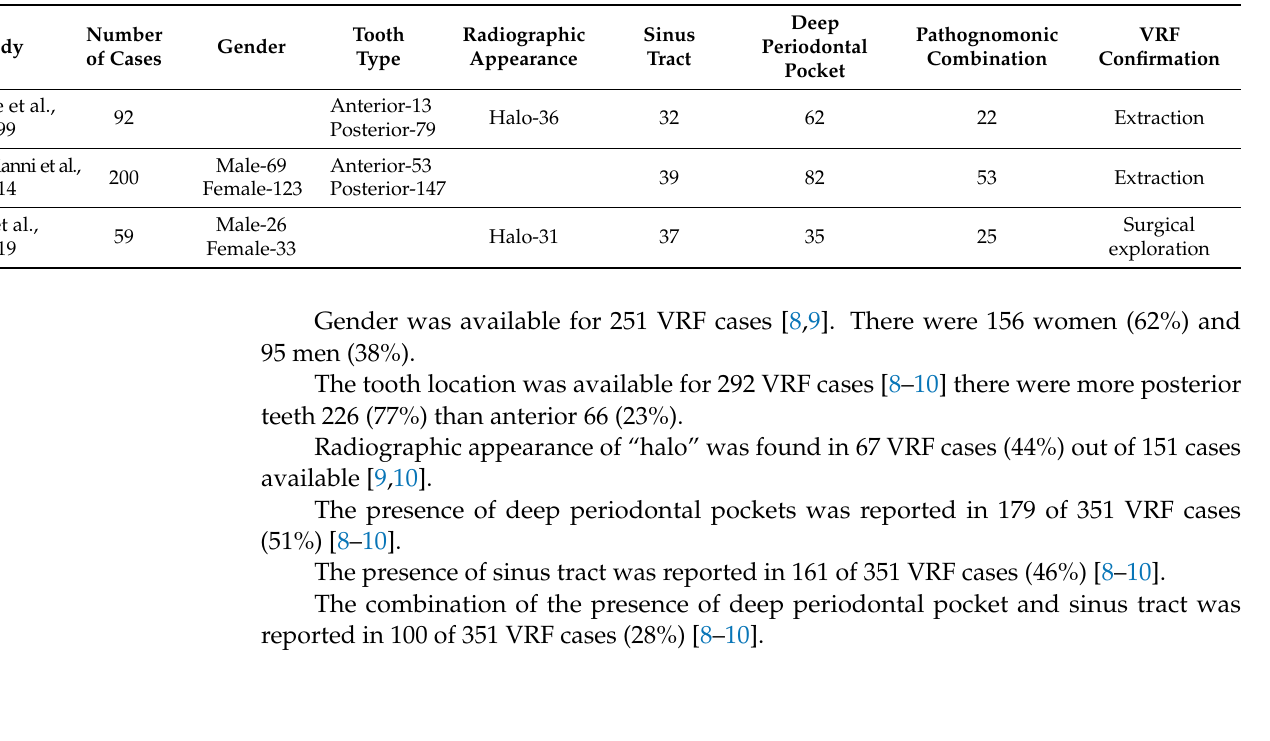
Table 1. The characteristics of the included